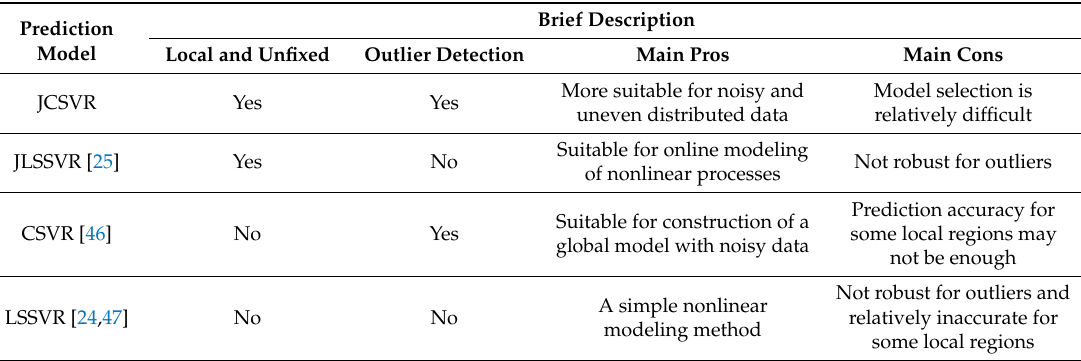
Table 2. Brief description of four different prediction models.